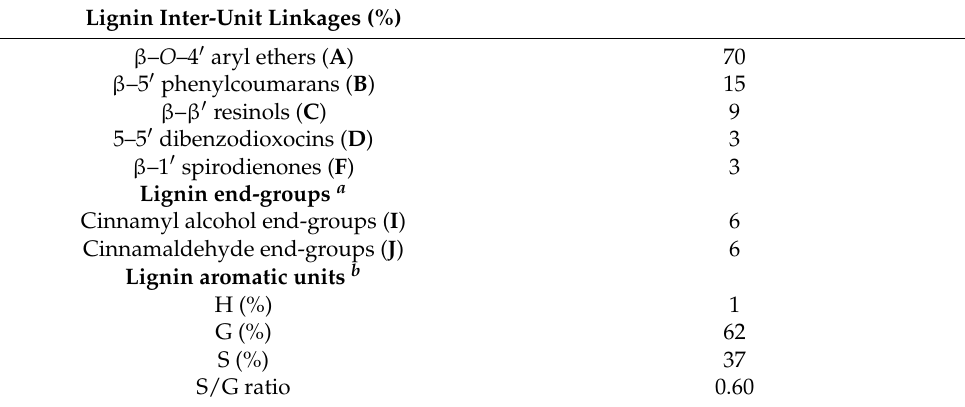
Table 4. Structural characteristics (inter-unit linkages, p -hydroxycinnamyl end-groups, H-, G-, and S-lignin units, and S/G ratios) from integration of the signals in the 2D-NMR (HSQC) of the MWL isolated from OTP